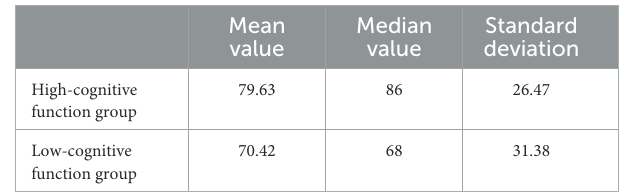
TABLE 3 Mean value, median value, and standard deviation of epoch size in high- and low-cognitive function